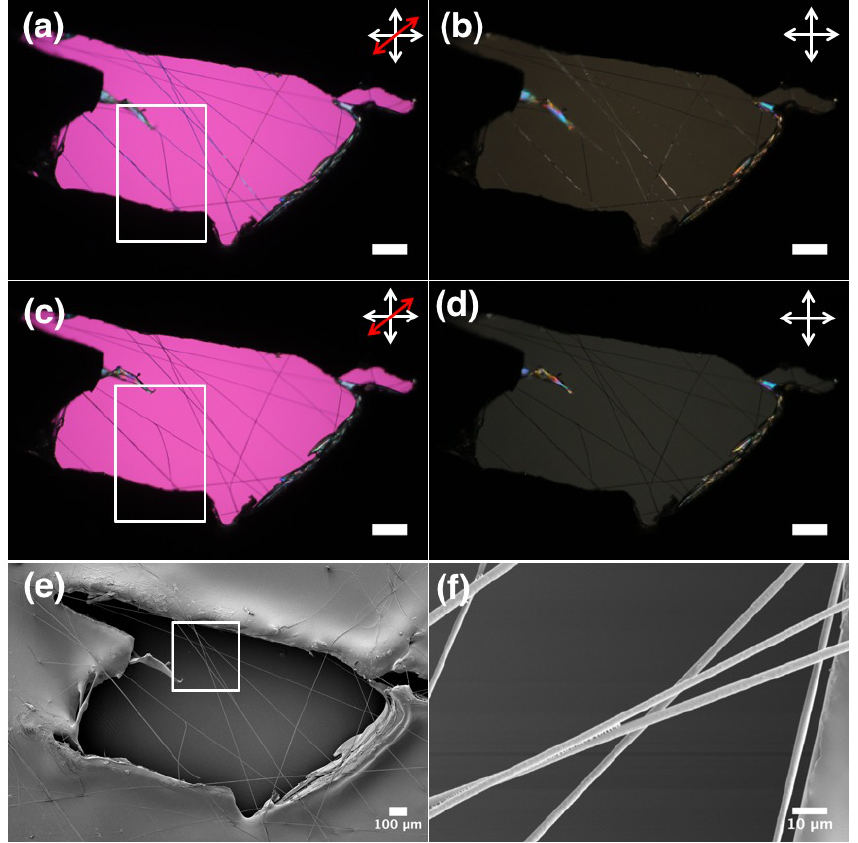
Figure 5. POM image of LCE-PVP fibers ( a , b ) at 20 ◦ and ( c , d ) in the isotropic phase at 70 ◦ C; ( e , f ) SEM images of the same sample heated to 75 ◦ C. Images a and b are with red wave plate between crossed polarizers (scale bars for images ( a – d ): 200 µ m). The white double-ended arrows depict the orientation of polarizer and analyzer, respectively, and the red double-headed arrow in ( a , c ) shows the direction of optic axis of a first-order λ plate inserted in the light